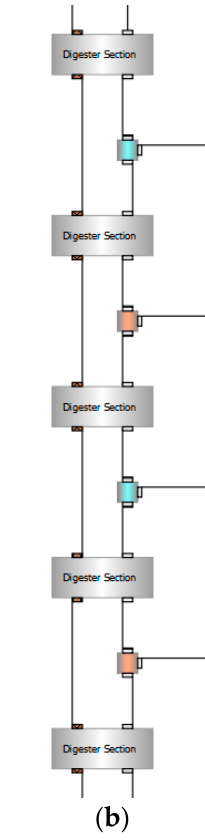
Figure 3. Object-oriented model of continuous pulp digester in OpenModelica. ( a ) Complete digester and ( b ) impregnation